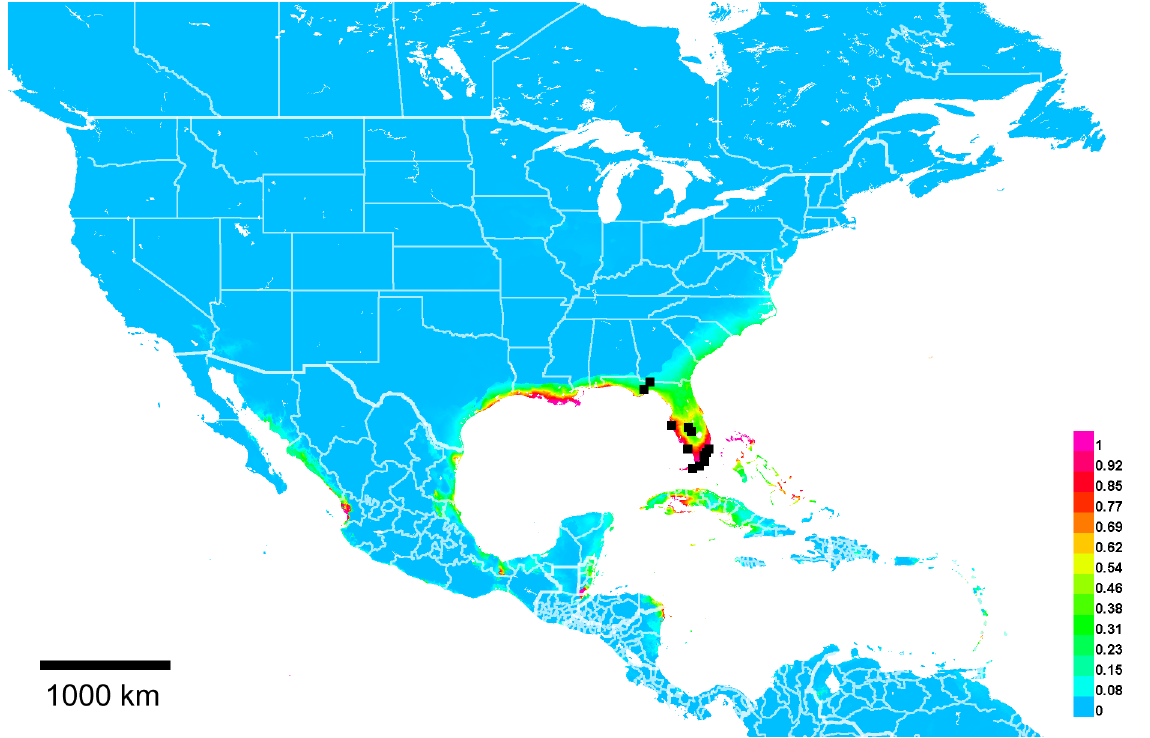
Fig. 41. Georeferenced collection records of Lasioglossum ( D .) lepidii (Graenicher, 1927) (black squares) and predicted distribution by maximum entropy ecological niche modelling in Maxent (colour shading). Warmer colours indicate higher cloglog probability of occurrence. Because many coastal records lacked soil data, the model was generated without soil type as an environmental